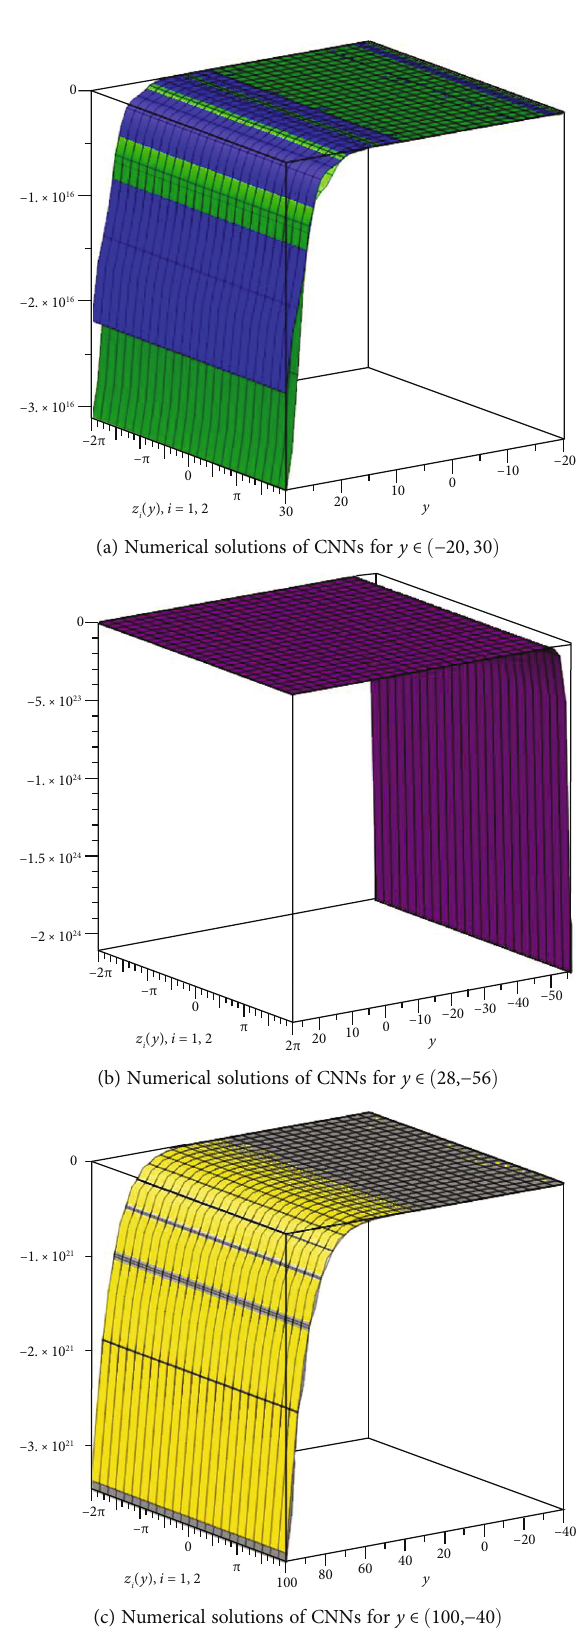
Figure 1: Graphs related to numerical solutions of CNNs (1) for di ff erent